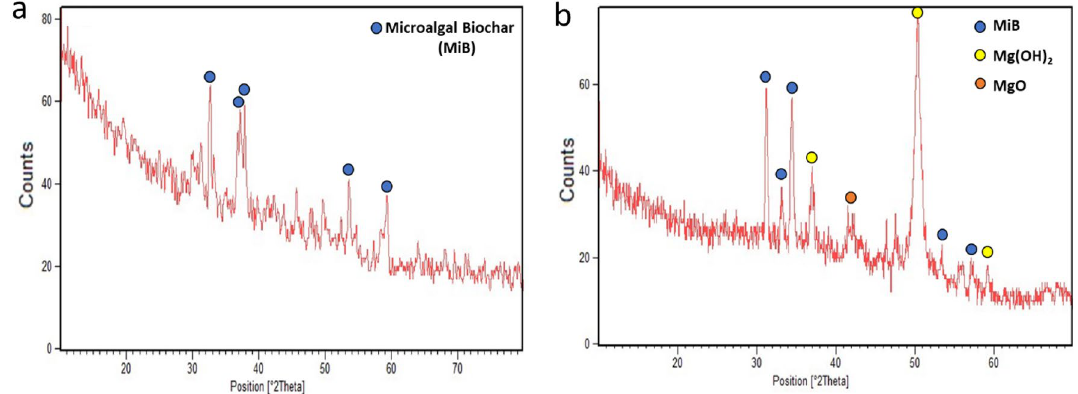
Figure 2. X-Ray diffraction graphs of ( a ) microalgal biochar 12 ( b ) Mg-laden microalgal biochar used in this study.